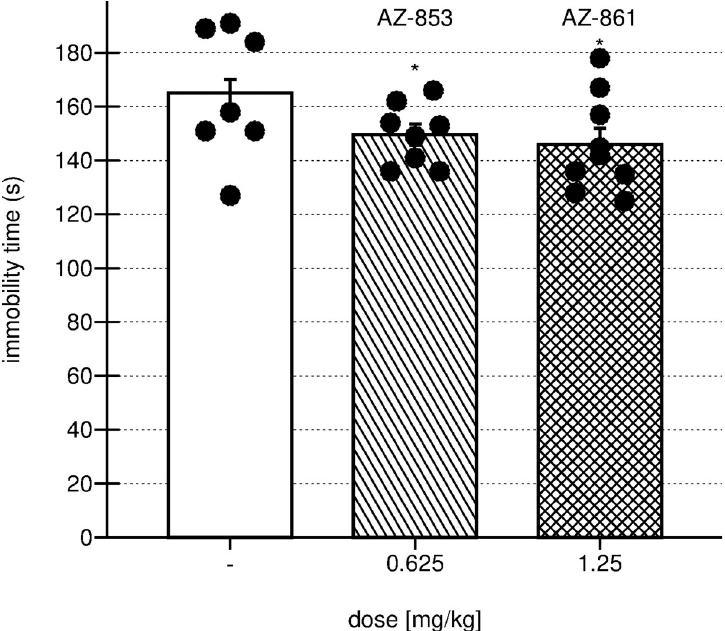
Fig 5. Effect of repeated administration of AZ-853 and AZ-861 on duration of immobility on FST in mice. AZ-853 and AZ-861 administered i . p . once daily for 13 consecutive days. Data represent mean ± SEM, n = 7–8 mice per group; one-way ANOVA followed by Bonferroni’s post hoc test; � p < 0.05 vs. control group.